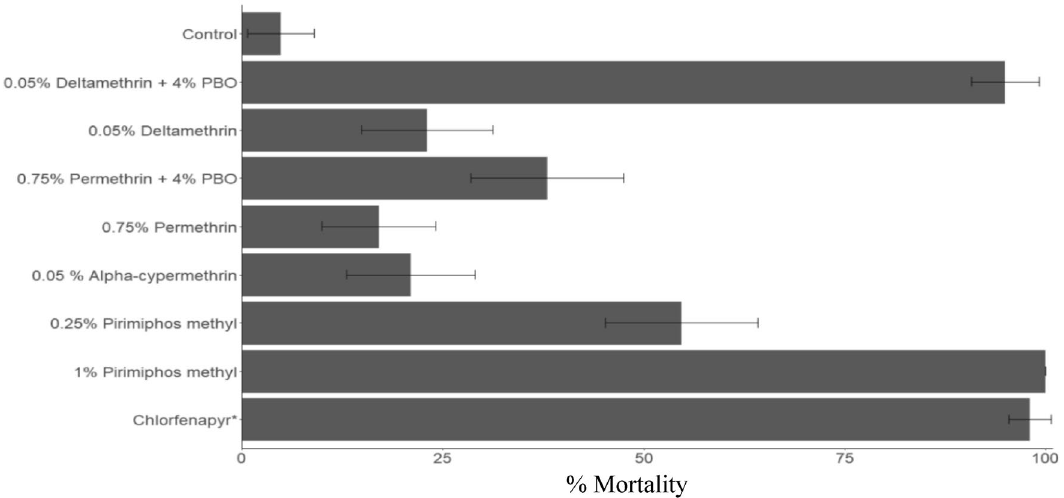
Figure 3. Mortality (%) of wild An. gambiae s.l. from Bouaké, Côte d’Ivoire exposed to insecticides in WHO susceptibility bioassays. Error bars indicate 95% confidence intervals. *Susceptibility assays with the pyrrole insecticide chlorfenapyr was performed using CDC bottle assays.